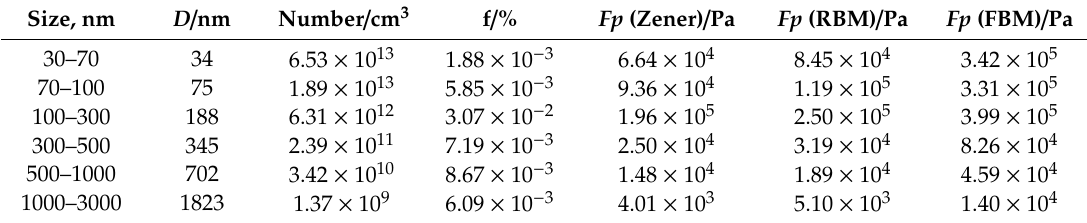
Table 5. The calculated pinning forces ( Fp ) of precipitates-annealed sheet samples. Size,